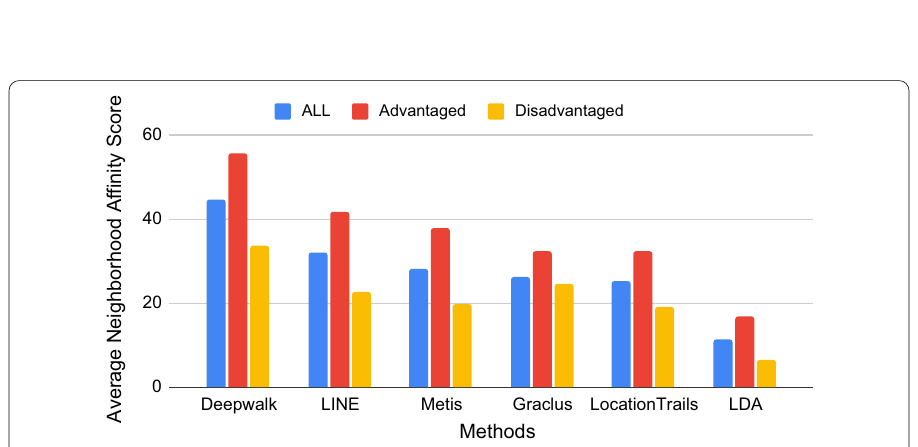
Fig. 10 Average neighborhood affinity score in the advantaged (poverty ≤ 20%) and disadvantaged neighborhoods (poverty ≥ 40%) (Jargowsky 2013). Number of communities